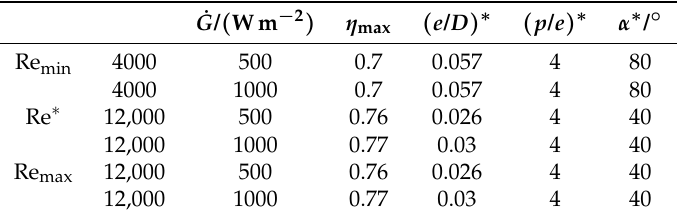
Table 5. Maximum efficiency and optimum roughness parameters according to the model developed by Deo et al.